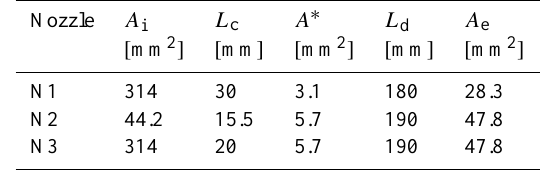
Figure 2. Geometry of the Cold Spray nozzle.